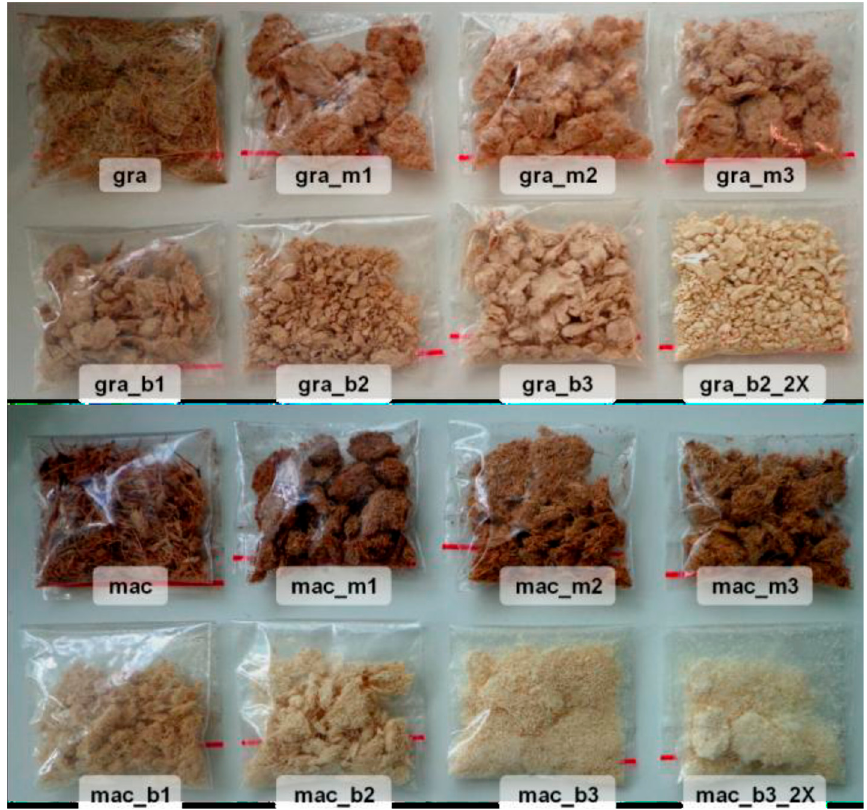
Figure 2. Images of raw fibers of gravata and macauba, and mercerized and bleached fibers, with their respective coding.